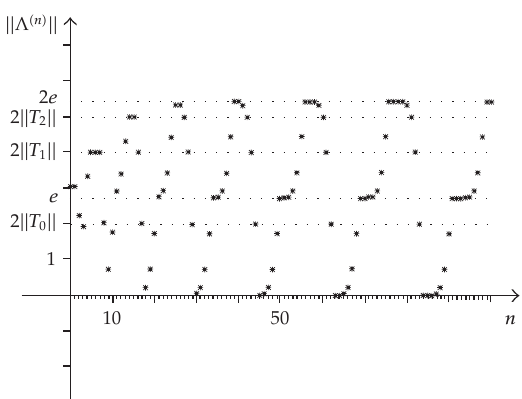
Figure 2: The sequence (cid:7) (cid:7) Λ (cid:7) n (cid:8) (cid:7) (cid:8)